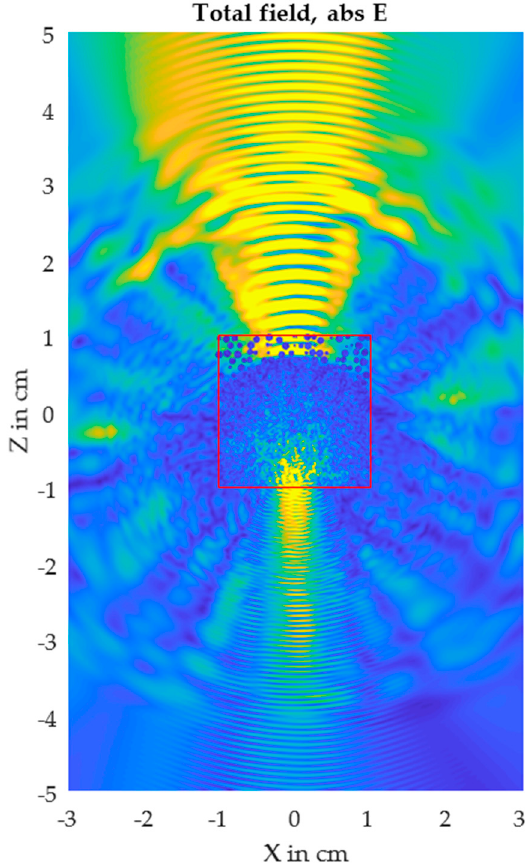
Figure 9. Simulated scattering behavior of 6345 particles, 1 mm in diameter, at a wavelength of 1 mm. A 20 mm-thick sample was simulated. The incident beam originates from the top axis.